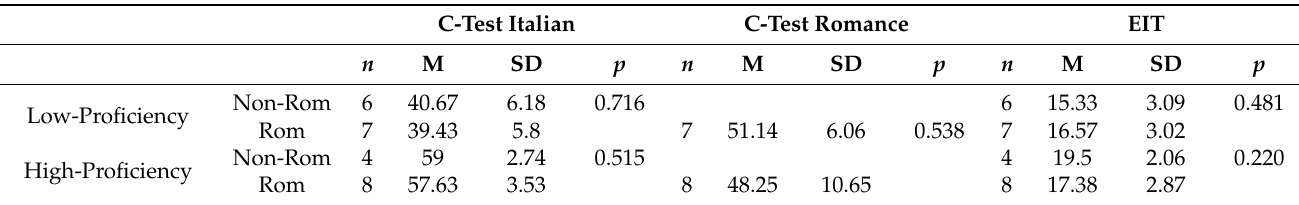
Table 3. Number of participants ( n ), Mean score (M), standard deviation (SD) and p-values ( p ) for the C-test in Italian, the C-test in Romance and the English Interpretation Test